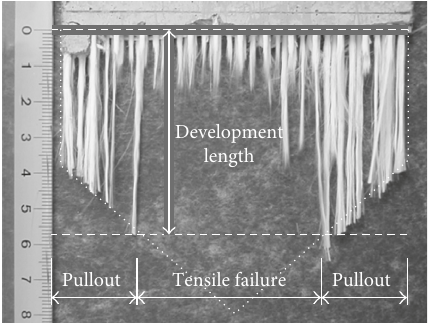
Figure 7: Obtaining the development length of cone-shaped